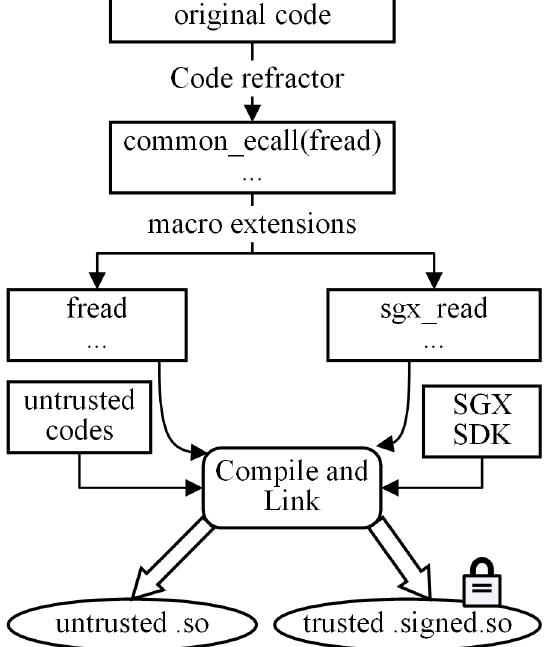
Figure 2. The backward-compatible compilation model for refactoring the code of a DNS